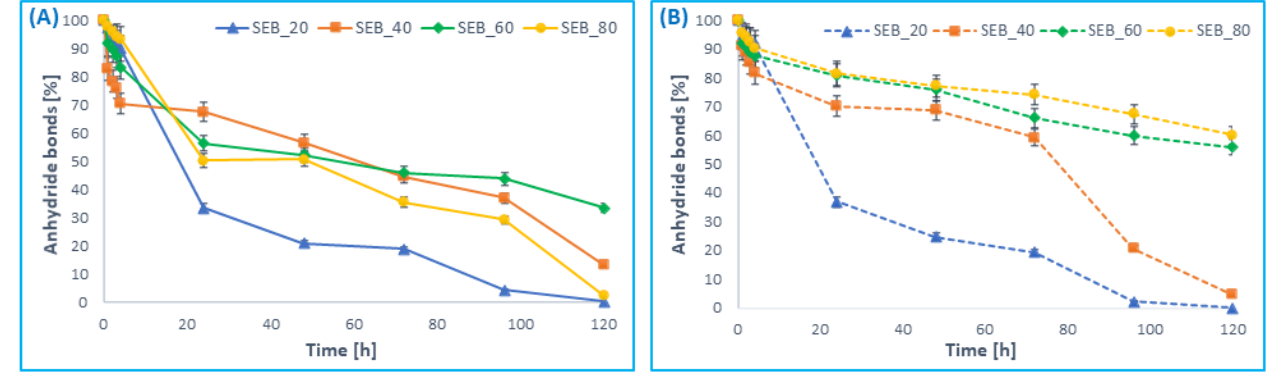
Figure 4. Anhydride bond loss of DBB-SEB polyanhydrides, for DBB segments ( A ) and SA segments ( B ) during hydrolytic degradation in phosphate buffer conducted at 37 °C ( n = 3, error bars, standard deviation).